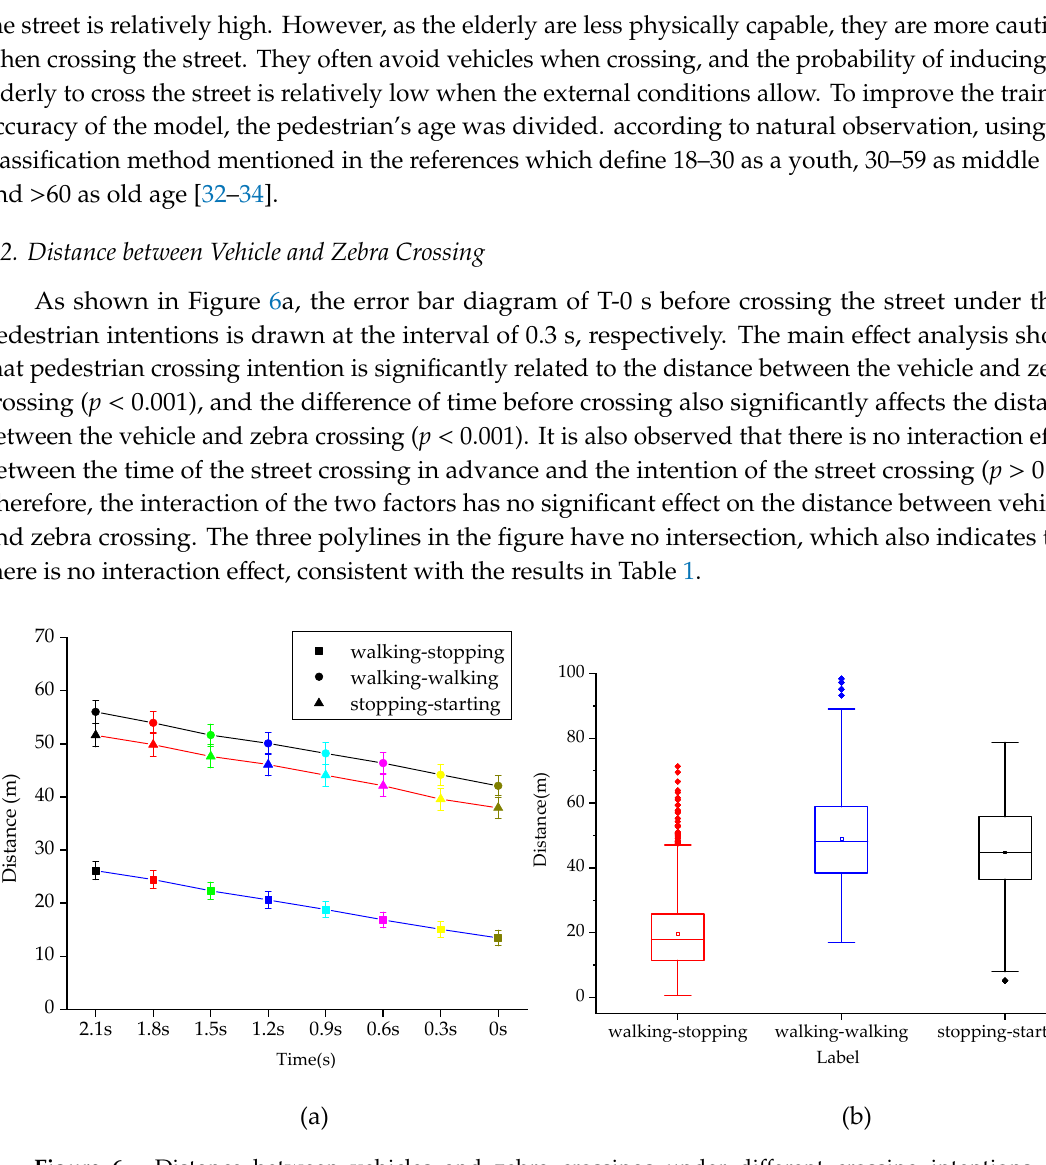
Figure 6. Distance between vehicles and zebra crossings under different crossing intentions. ( a )The distance between vehicles and zebra crossings at different times and with different intentions. ( b ) Mean distance between vehicles and zebra at crossings under different intentions. Table 1. Main effect test table.